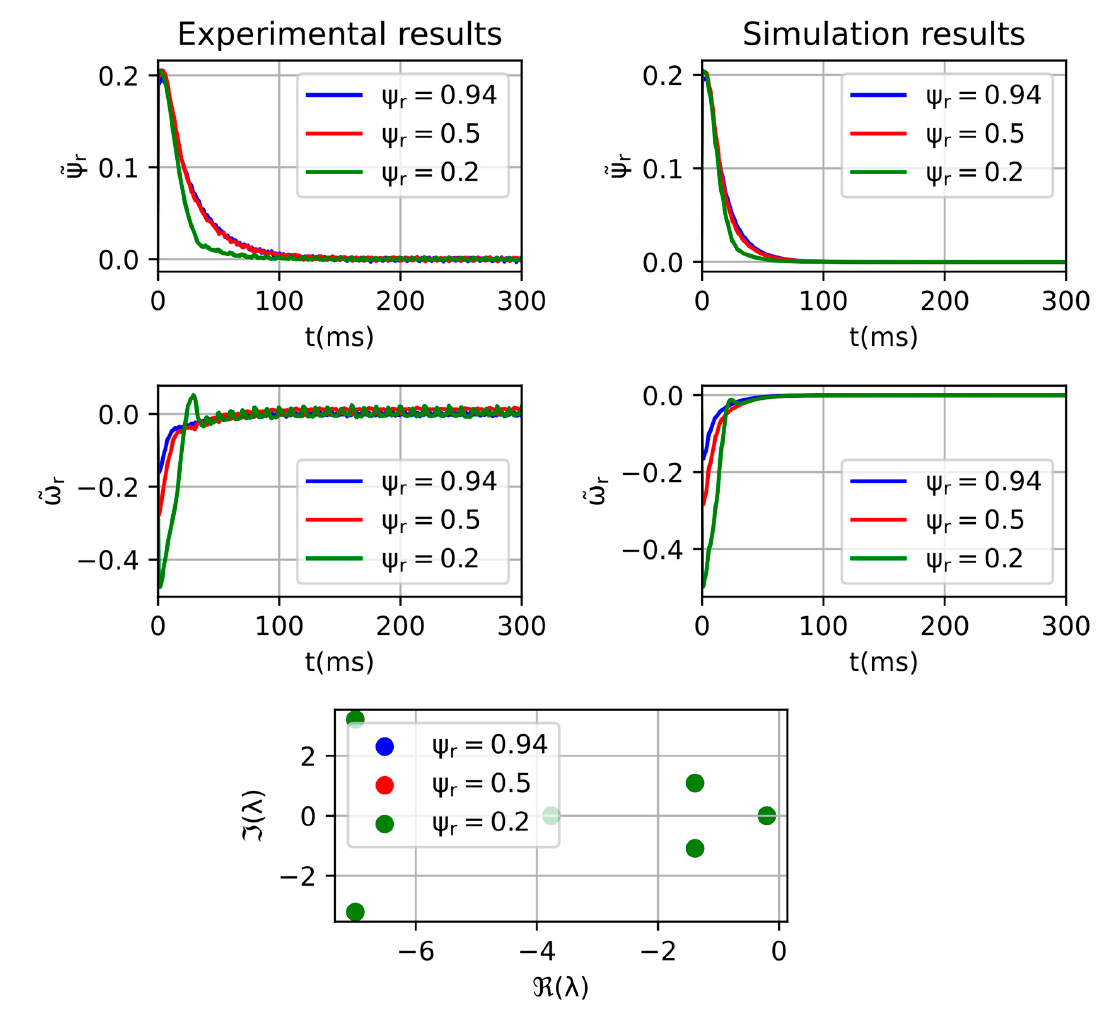
Figure 13. Experimental and simulation studies of the influence of the rotor flux on the poles placement and impulse response of the observer at nominal rotor speed and no load.